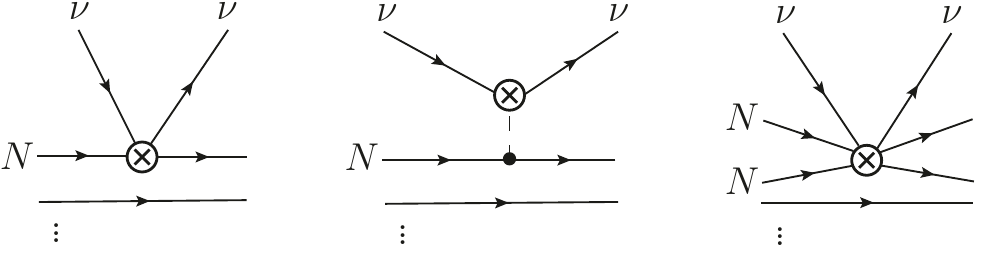
(cid:23) ( p 2 ) N ( k 2 ). !